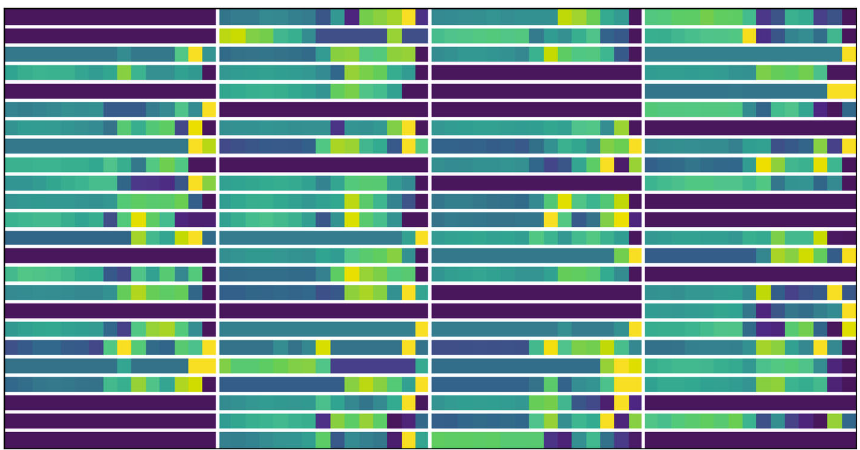
Figure 18: Feature visualization of the fourth convolution layer (96 in total).